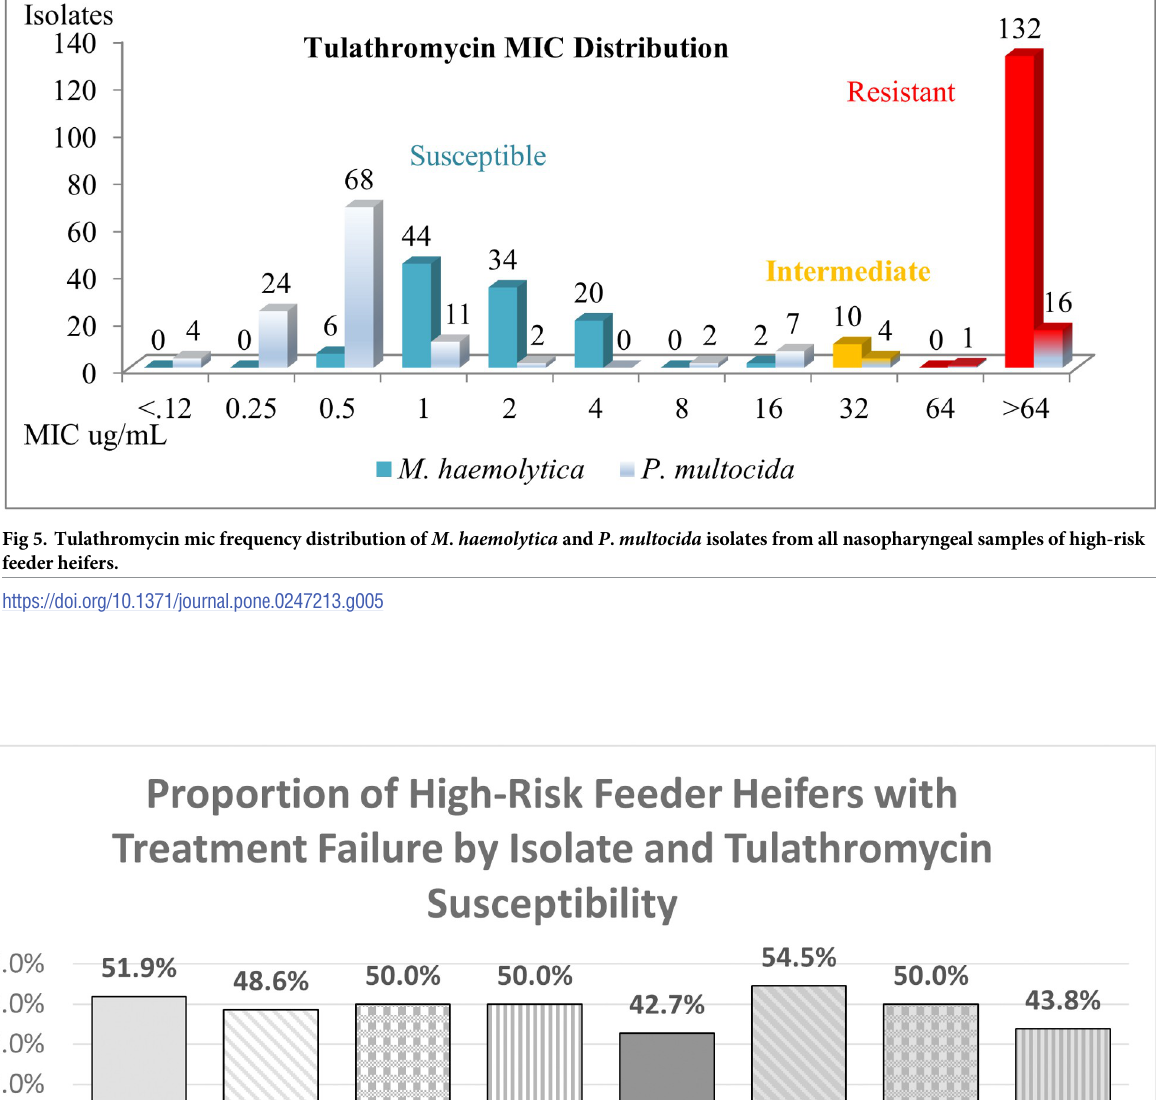
PLOS ONE | https://doi.org/10.1371/journal.pone.0247213 February 10, 2022 13 /